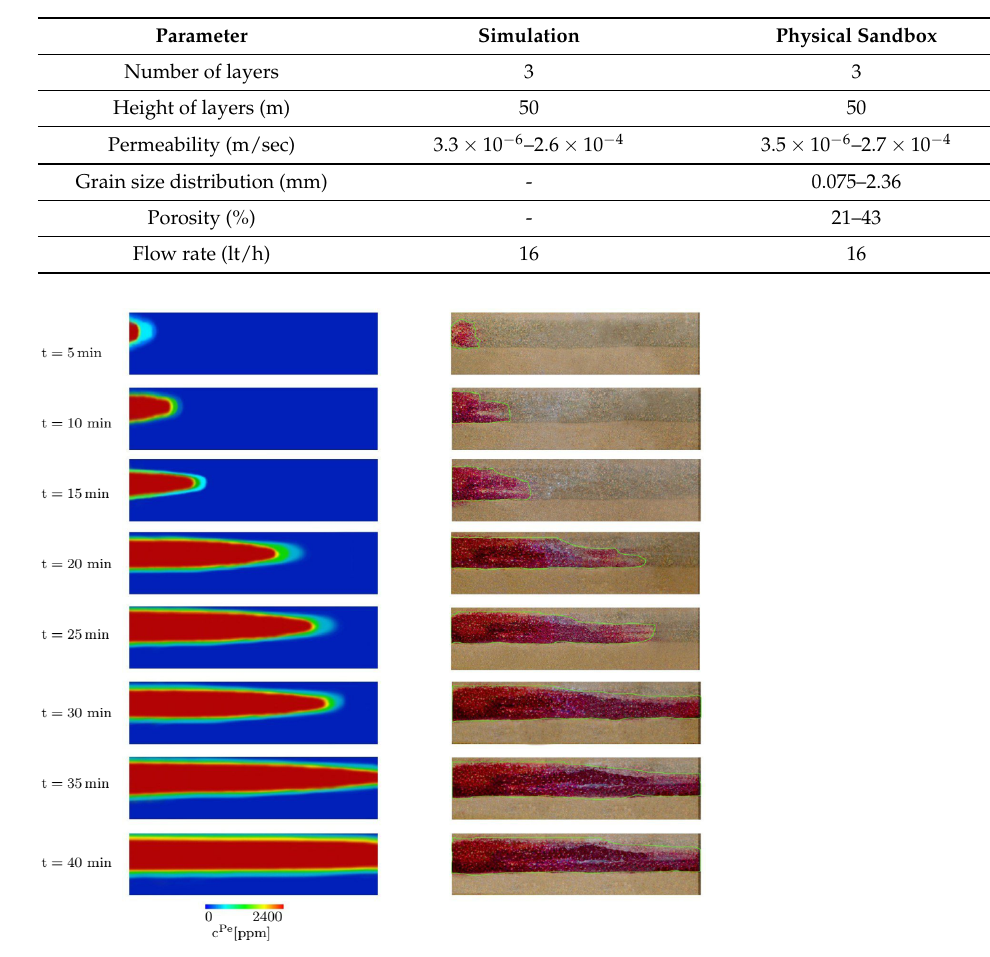
Table 3. Used parameters for simulation and physical sandbox experiment.